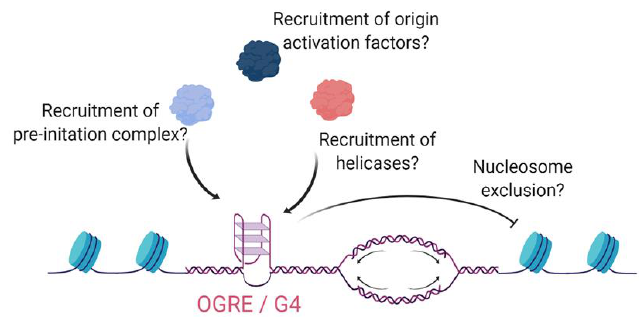
Figure 3. Promotion of replication origin firing by a G4-forming sequence. The Origin G-rich Repeated Element (OGRE) lies 250–300 bp upstream of the replication initiation site, in a nucleosome-free region, and is needed for optimal origin activity of a subset of vertebrate replication origins [90,92,94]. Figure created with BioRender.com.